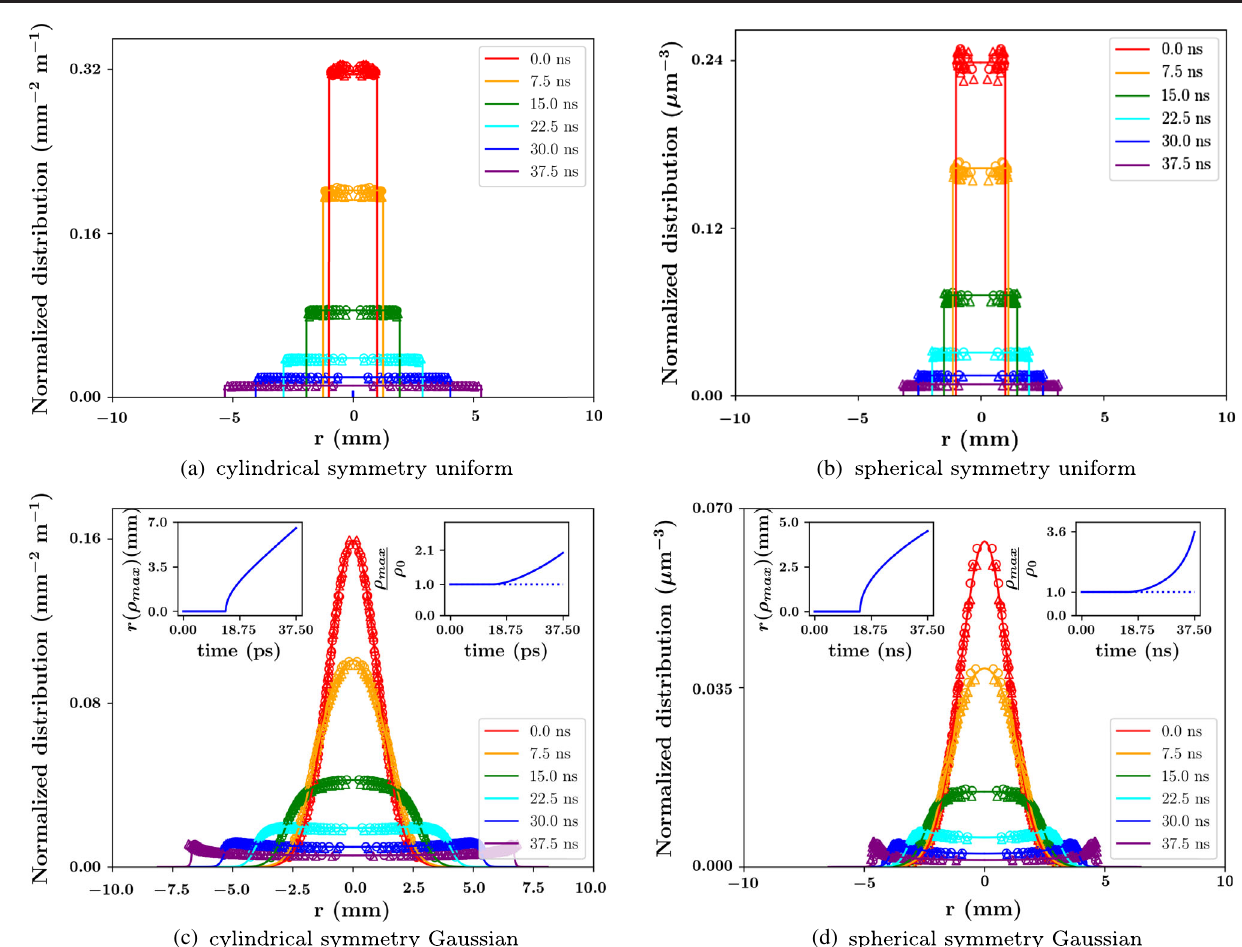
FIG. 6. Analytical (solid line), PIC (circles) using an ES solver and relativistic particle pusher, and electrostatic N-particle (triangles) results of the normalized density evolution of (a,c) cylindrically and (b, d) spherically symmetric (a, b) uniform and (c,d) Gaussian distributions with R ¼ σ r ¼ 1 mm and N of 1 . 875 × 10 4 electrons = mm, 2 × 10 4 electrons, 3 . 75 × 10 7 electrons = mm, and 10 5 electrons, respectively. The subgraph in the upper left corner of (c, d) shows the analytic position of max density as a function of time, and the subgraph in the upper right of (c, d) shows the analytic ratio of the max density to the density at the minimum r value both. The corresponding analytic ratio for the uniform distribution is shown in this sub-graph as a dashed horizontal line at 1. Unsurprisingly, the PIC results and the analytical results, both mean-field models, are in almost perfect agreement, and the N-particle results are in surprisingly good agreement as well. Notice that the models predict peak formation on a time-scale dependent on the initial plasma frequency similar to the peak formation seen in the N-particle disclike density evolution seen in Fig. 1(e) and detailed in Fig.